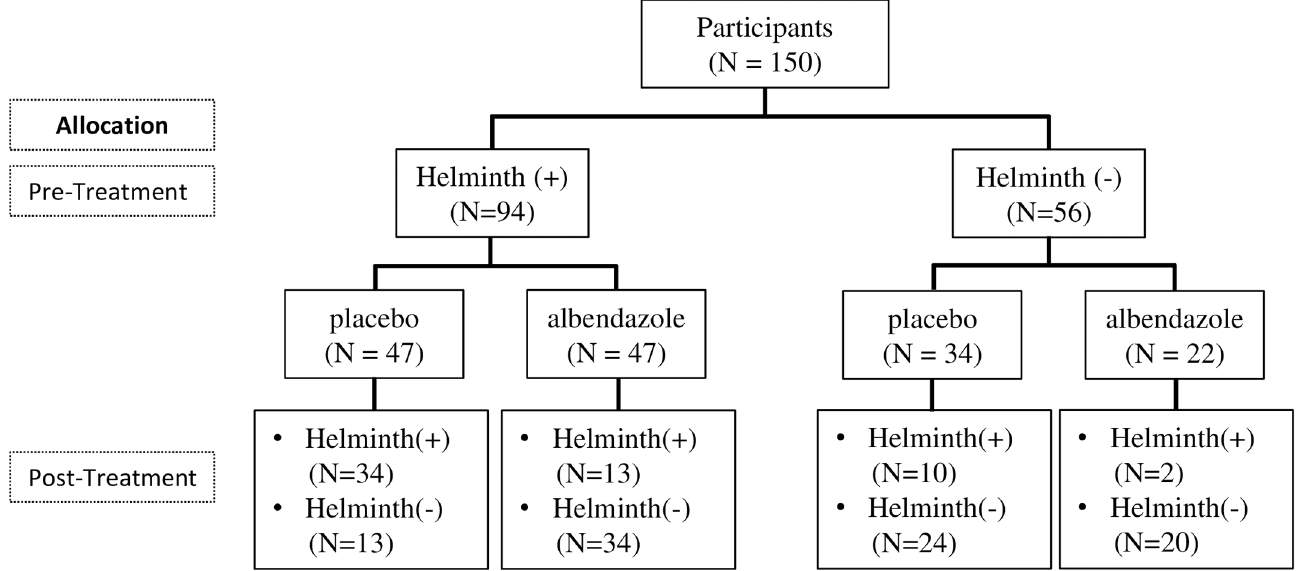
Fig 1. The profile of the microbiome study. The chart shows the number of subjecs infected with at least one of the prevalent soil transmitted helminths (Helminth (+)) or free of helminth infection (Helminth (-)) that belonged to either the placebo or albendazole treatment group, at pre-treatment and 21 months after